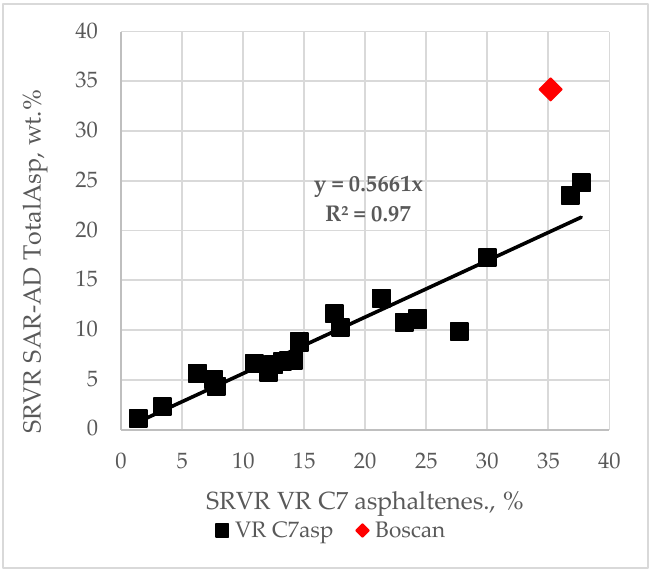
Figure 8. Relation of LNB C 7 -asphaltene content to the SAR-AD TM total asphaltene content.